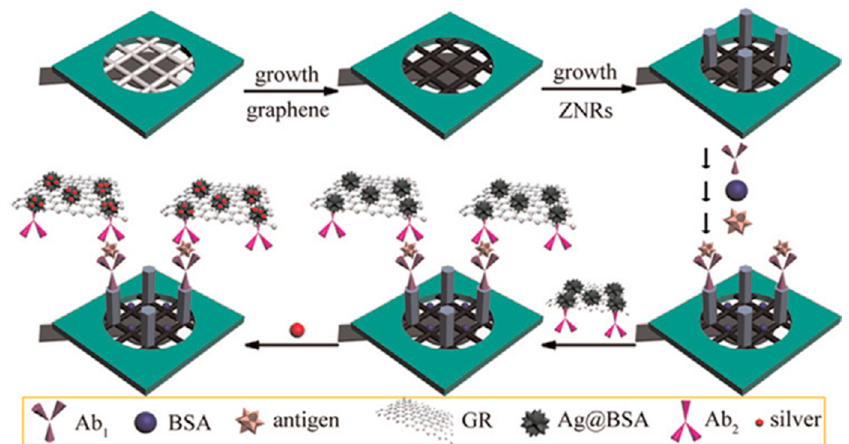
Figure 13. Fabrication process of the paper electrode-based immunosensor exemplified for one analyte. Reprinted from Ref. [100] with permission.